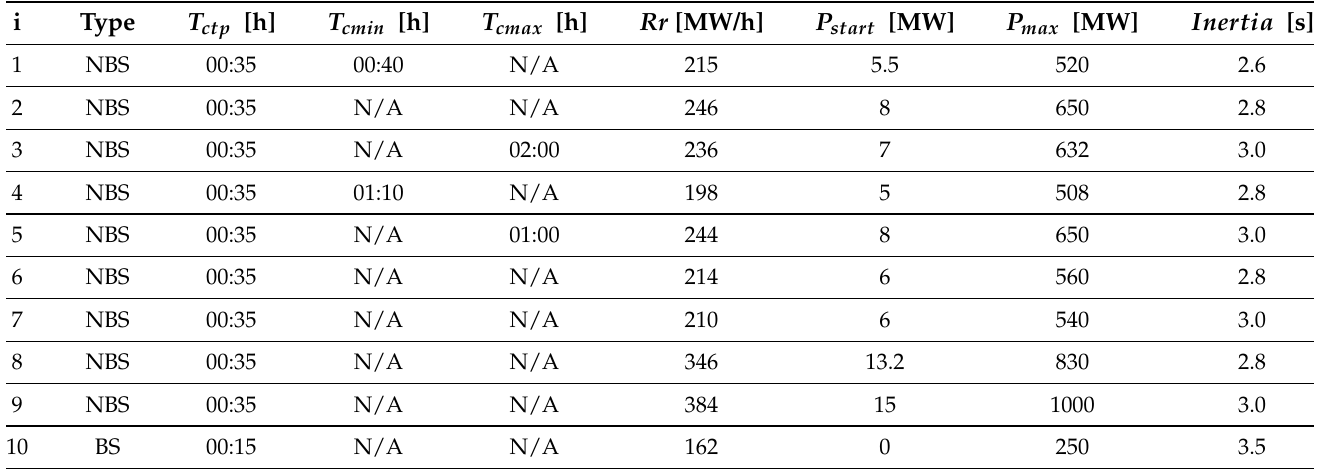
Table 2. Generation parameters of the IEEE-39 RTS sytem.